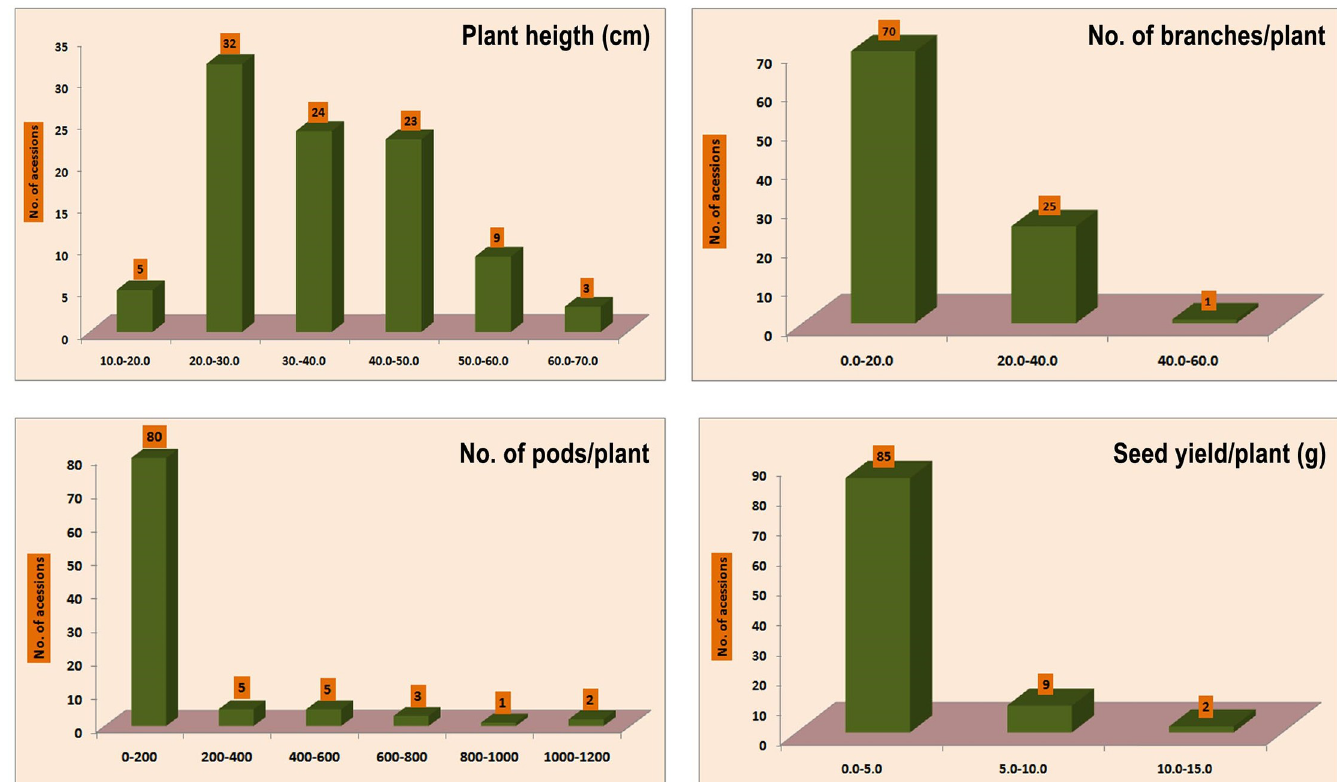
Fig 1. Diversity of wild lentil accessions for important quantitative traits.